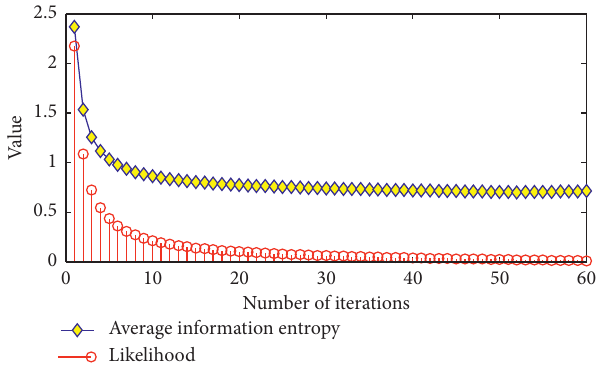
Figure 4: Trend chart of average information entropy and like- lihood value with increasing number of